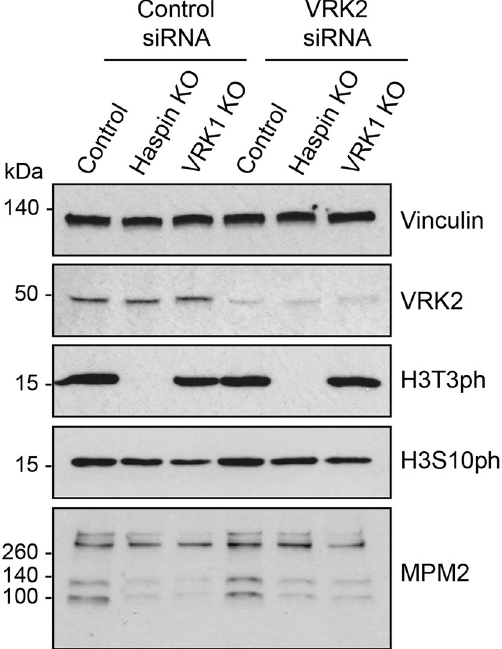
Figure 6. RNAi of VRK2 does not have a detectable influence on H3T3ph. Control and VRK1 KO HAP1 cells were treated with control or VRK2 siRNAs and subjected to immunoblotting with the stated antibodies.